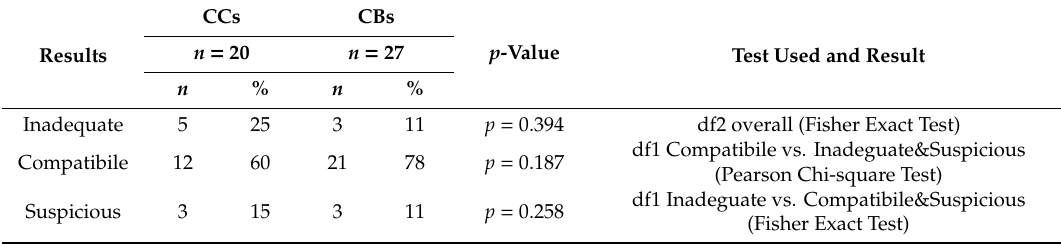
Table 2. Statistical comparison between CCs and